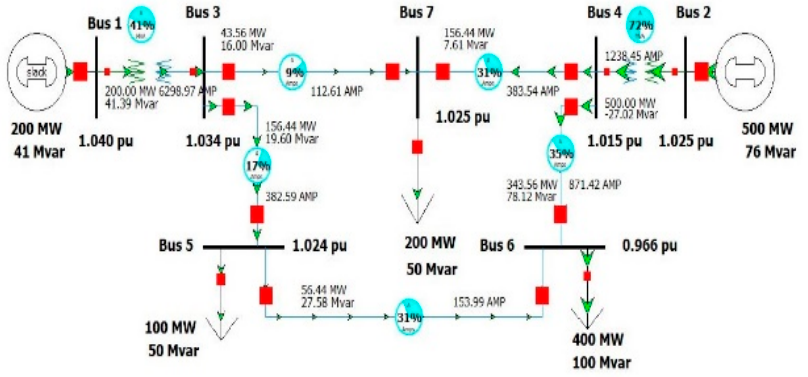
Figure 9. Base case power flow solution of the 7 bus power system network.